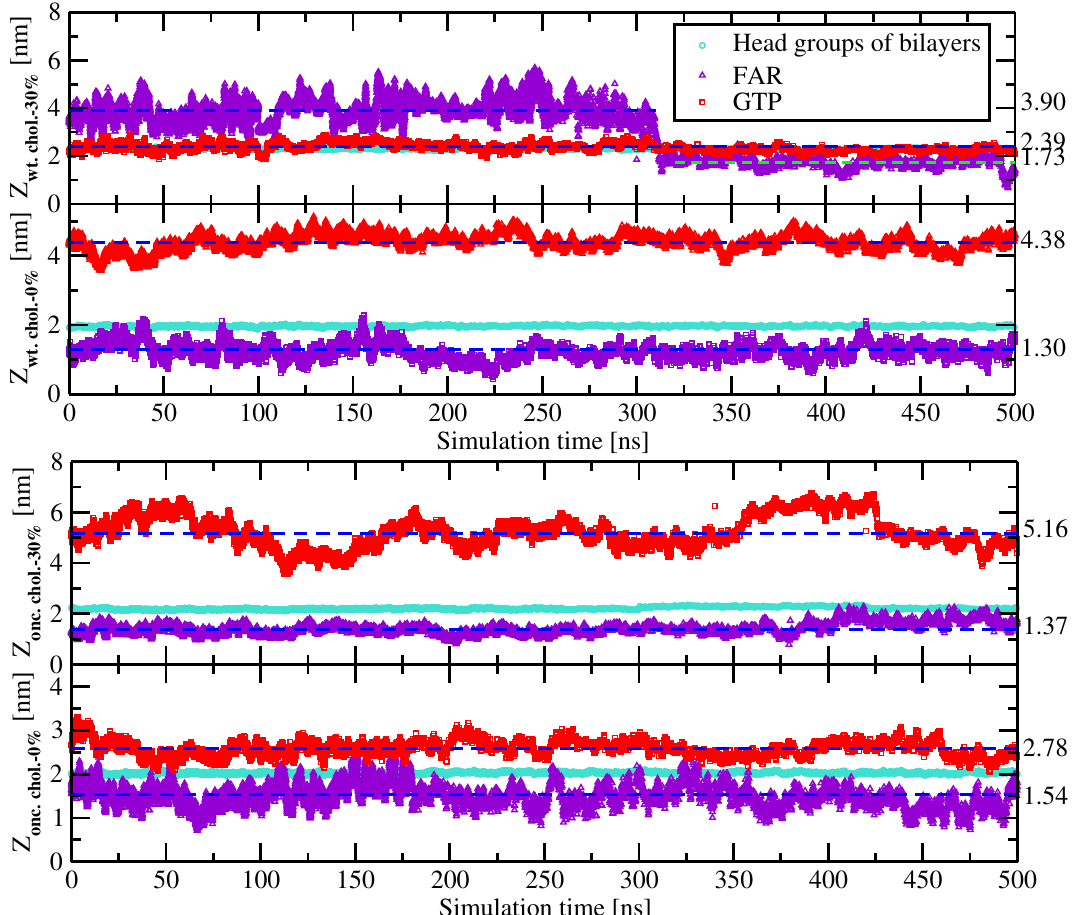
Figure 2. The localizations of the farnesyl group (FAR) and GTP of four KRas-4B systems studied in this work with respect to the center of the membrane along with the membrane normal as a function of simulation time. Geometric centers of the FAR, GTP, and phosphorus atoms of DOPC lipids from both leaflets are indicated as triangle up in violet and circle in turquoise, respectively. Data for chol.-30% shown here are adopted from our previous work [24] for the convenience of the audience. The average values of the FAR and GTP are indicated in dashed